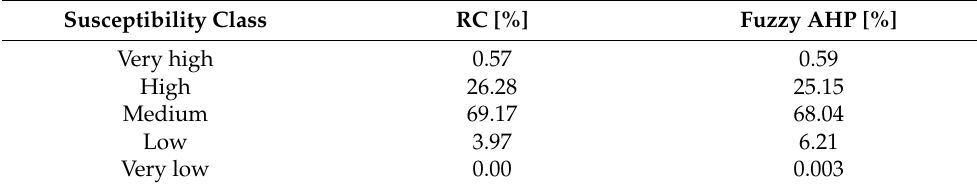
Table 10. Share of forest fire susceptibility zones in total MaB reserve